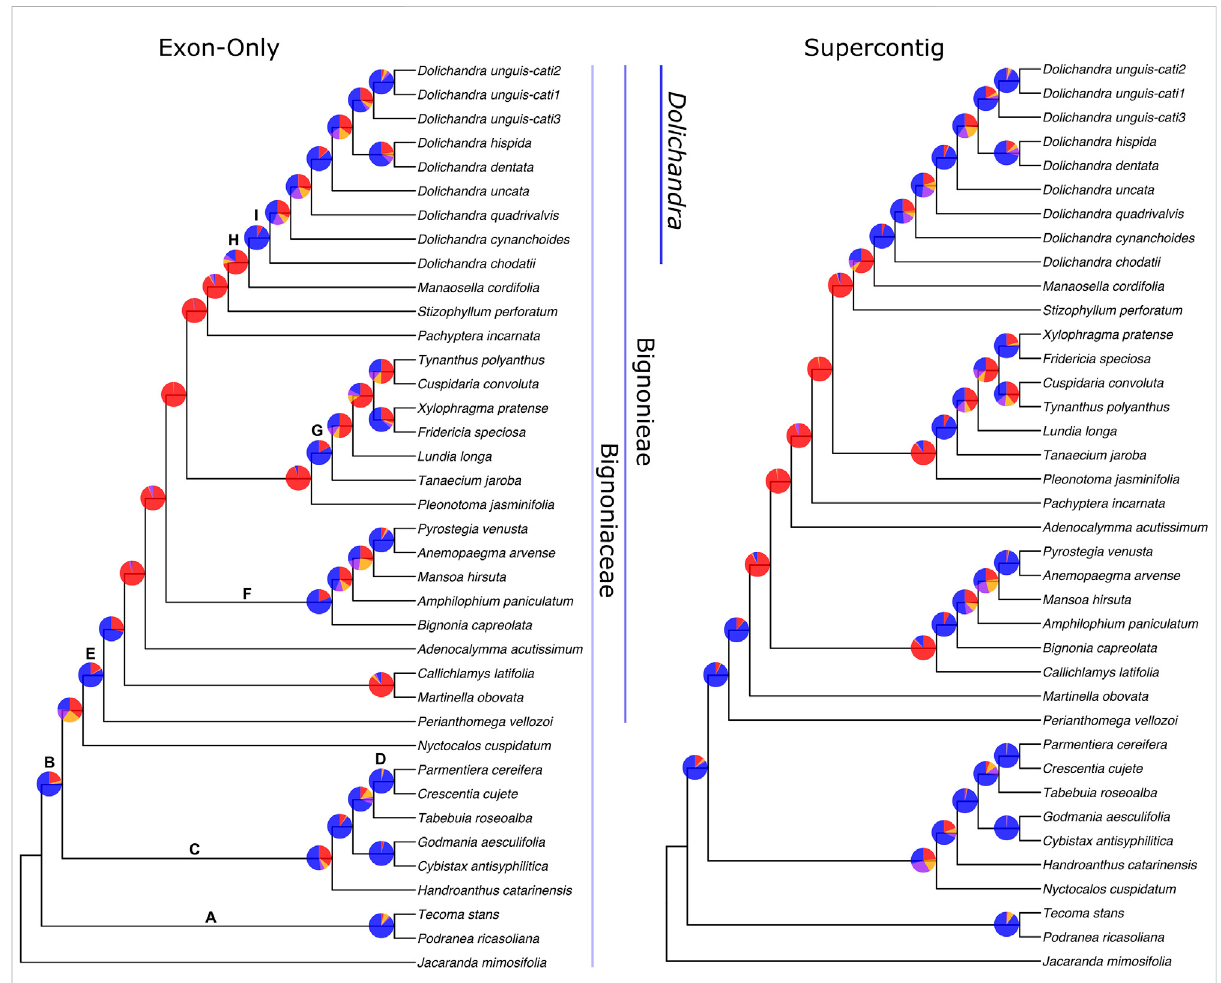
FIGURE 4 Phylogenies obtained through a coalescent approach and Exon-Only and Supercontig datasets. Gene concordance factor (gCF) values shown aspiecharts.ForgCFpiecharts,bluerepresentstheproportionofgenetreesconcordantwiththatbranch,purplerepresentstheproportionofgene trees concordant with the fi rst alternative quartet, orange represents the proportion of gene trees concordant with the second alternative quartet, and red represents the gene discordance support due to